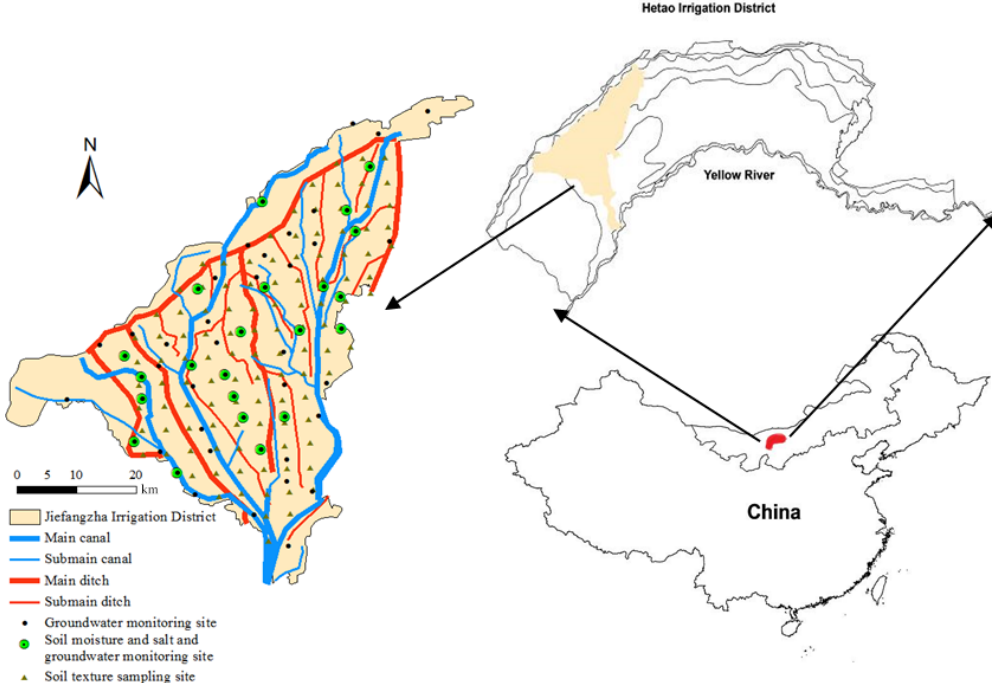
Figure 5. Location of the Jiefangzha Irrigation